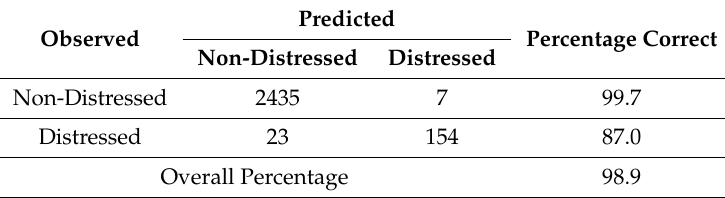
Table 6. Bayesian logit model—classification